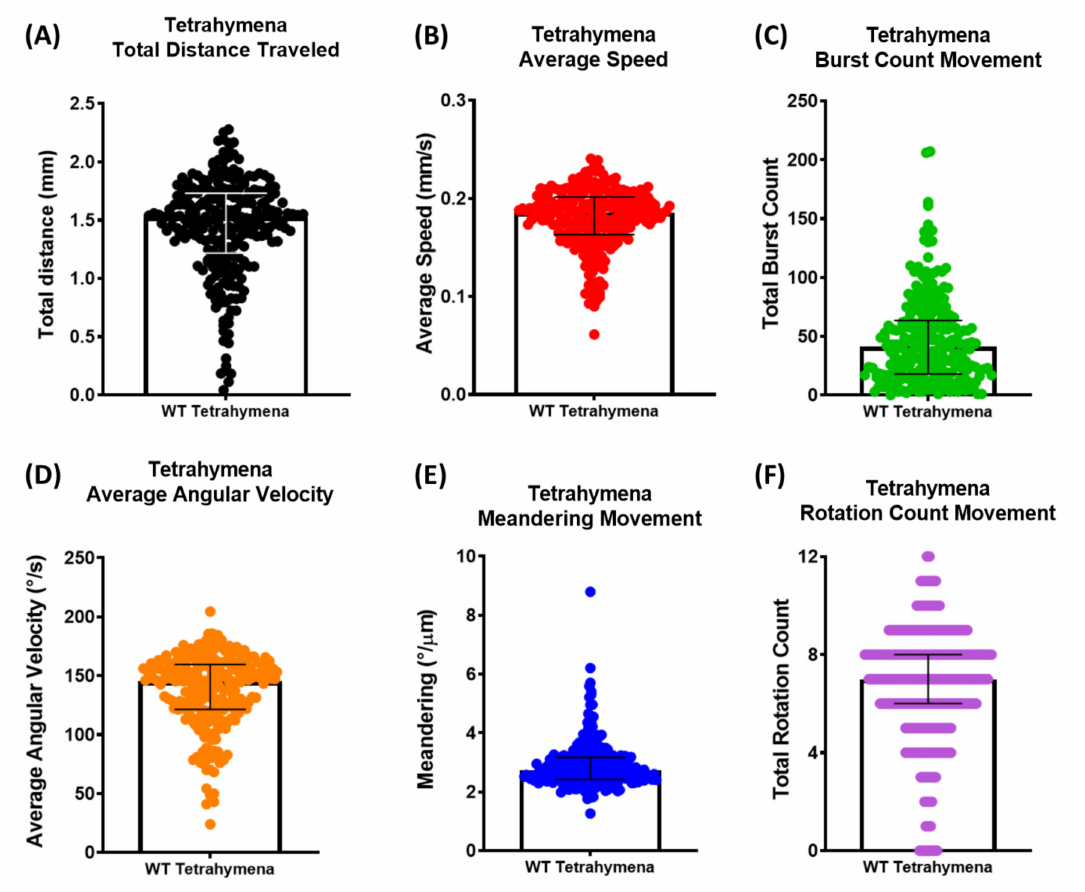
Figure 2. Summary of multiple endpoints of locomotor activity analyzed in T. thermophila . ( A ) Total distance traveled (mm), ( B ) average speed (mm/s), ( C ) total burst movement count, ( D ) average angular velocity ( ◦ /s), ( E ) meandering ( ◦ / µ m), and ( F ) total rotation movement count were calculated based on the 10 s video recording. Median and interquartile range are used to express the data ( n =